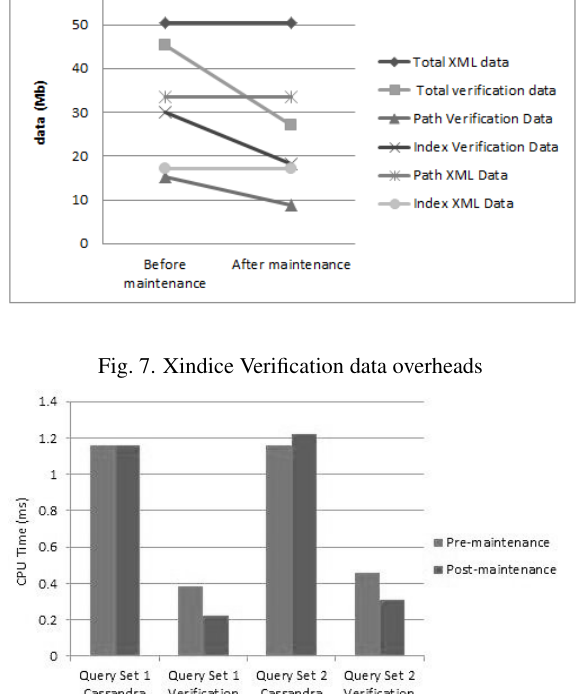
Fig. 8. Cassandra Experiment Computation